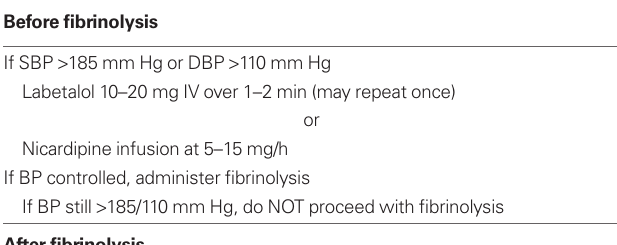
Table 3 | Management of arterial hypertension in patients with acute ischemic stroke who are candidates for